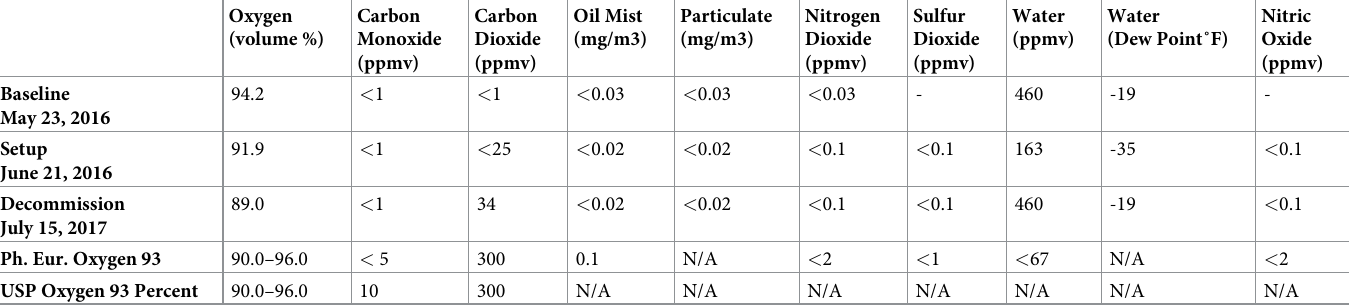
Table 1. Low-pressure reservoir gas quality testing and